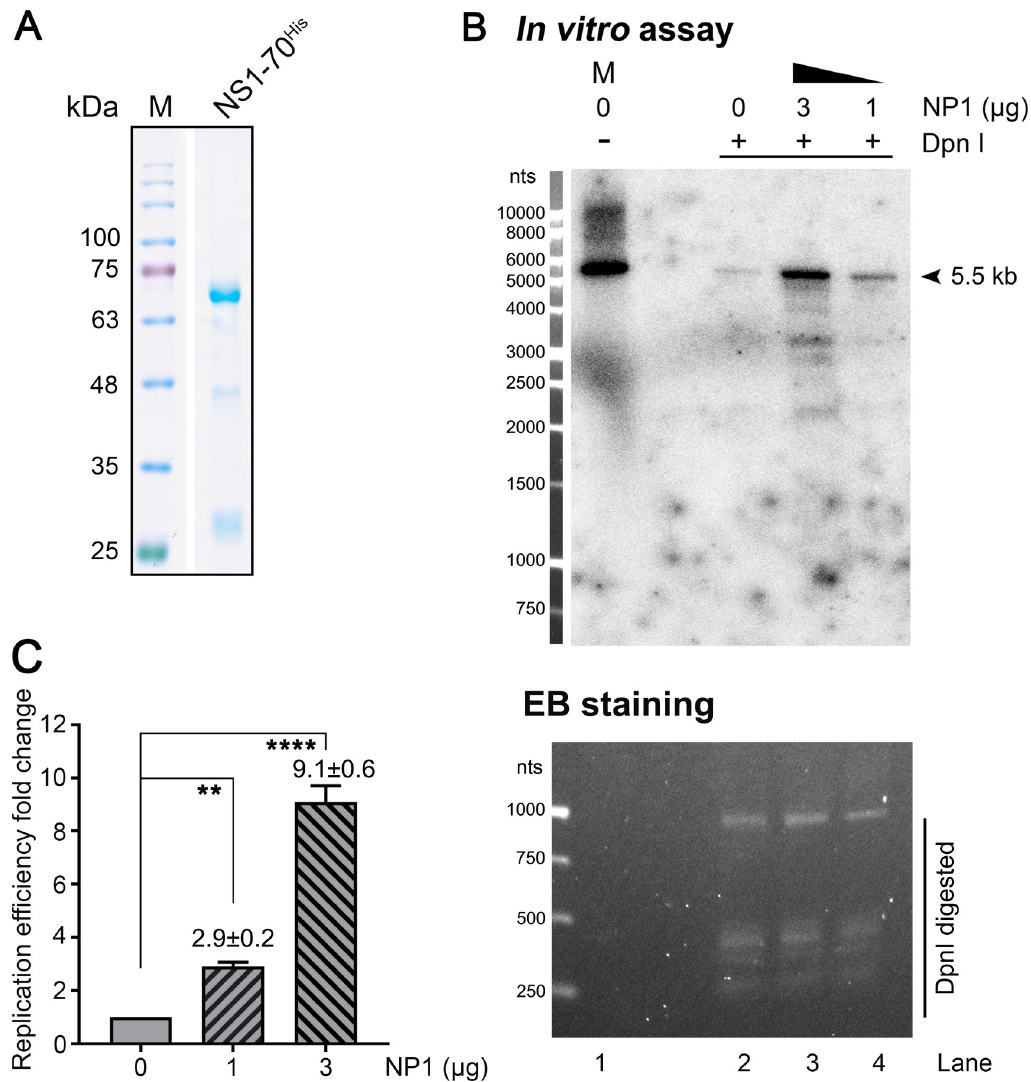
Fig 9. HBoV1 NP1 boosts HBoV1 DNA replication in vitro . (A) Purification of HBoV1 NS1-70 His protein. Purified HBoV1 NS1-70 His was analyzed on SDS-(12%)PAGE followed by Coomassie blue staining. (B) In vitro replication assay. NP1 His protein was added in two reactions at 1 μ g and 3 μ g, respectively, and the mock (0 μ g) NP1 reaction served as the control. After DpnI digestion, the in vitro replicated products (lanes 2–4) were resolved on 1% agarose gel in TAE buffer. Ethidium bromide (EB)-staining visualized the DpnI digested input template (lower panel). The gel was then dehydrated to dry and exposed to a phosphor screen. The signals were developed on a Typhoon FLA 9000 scanner (upper panel). Lane 1: the reaction without DpnI digestion was loaded as a size maker (M) at 5.5 kb. The arrowhead indicates the in vitro replicated HBoV1 DNA. (C) Quantification of the relative replication efficiency. The DpnI-digestion resistant (replicated) viral DNAs (signals) were quantified using ImageQuant Tl (IQTL) 8.2 software (Cytiva). The quantities obtained from three repeats are presented as relative levels to the control (lane 2, panel B), and were obtained from triple experiments. �� , P < 0.01; ���� , P < 0.0001.